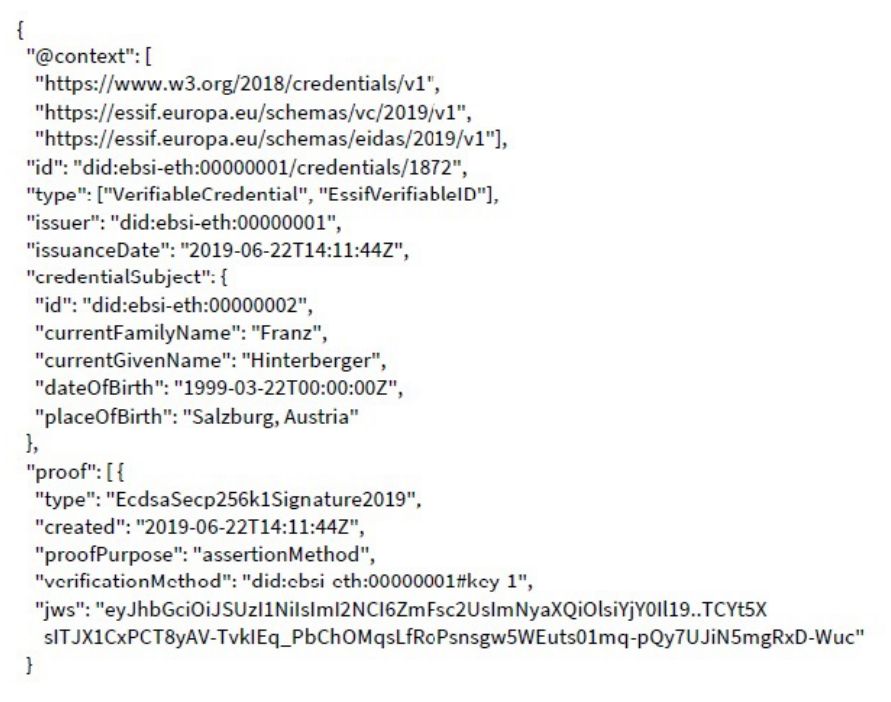
Figure 2. Format for Verifiable ID and Attestation signed with a DID